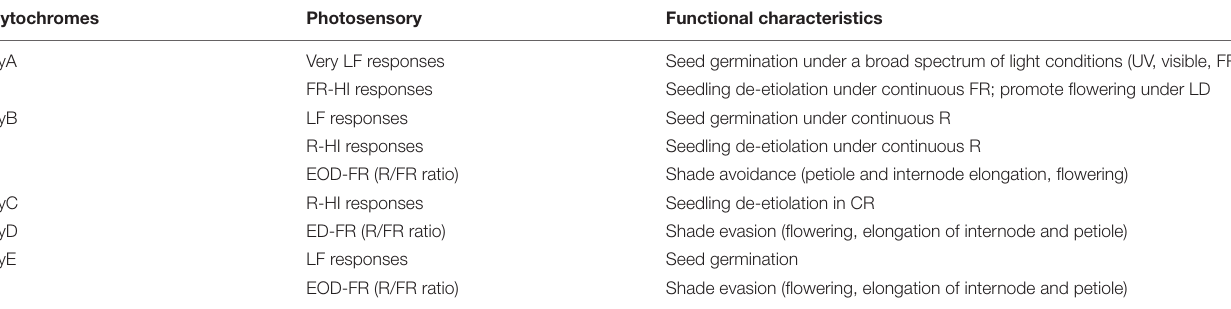
TABLE 1 | Photosensory responses and functional characteristics of phytochromes in the physiological growth and development of Arabidopsis thaliana .